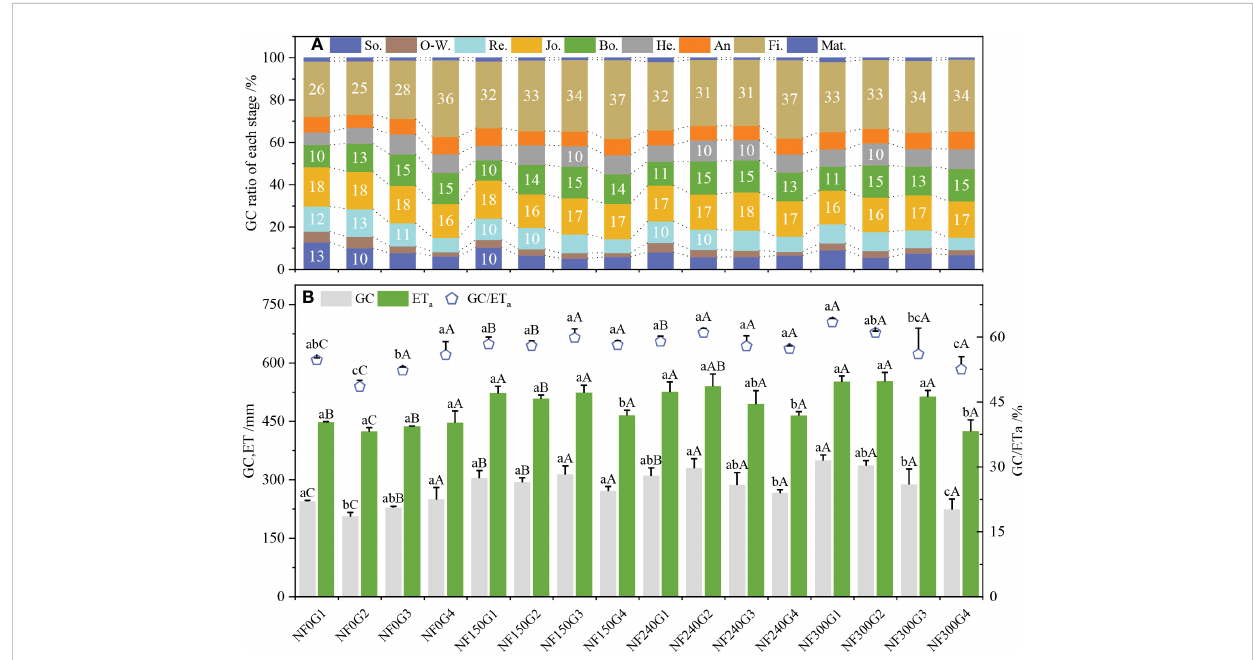
FIGURE 5 Proportion of GC of each stage, GC, ETa, and GC/Eta. Se., O-W., Re., Jo., Bo., He., An., Fi. and Mat. mean seeding, over-wintering, regreening, jointing, booting, heading, anthesis, fi lling and maturity stage, respectively. Different lowercase letters indicate signi fi cant differences were among different WTDs under the same N application rate, P < 0.05. Capital letters indicate signi fi cant differences among different N application rates under the same WTD, P < 0.05. The same is true below.